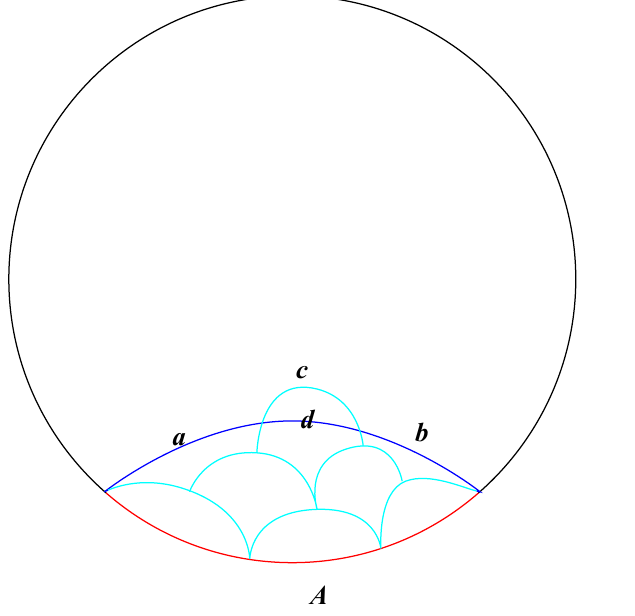
Figure 2 . The bulk minimal surfaces growing out of a boundary subregion A will not exceed the entanglement wedge of A